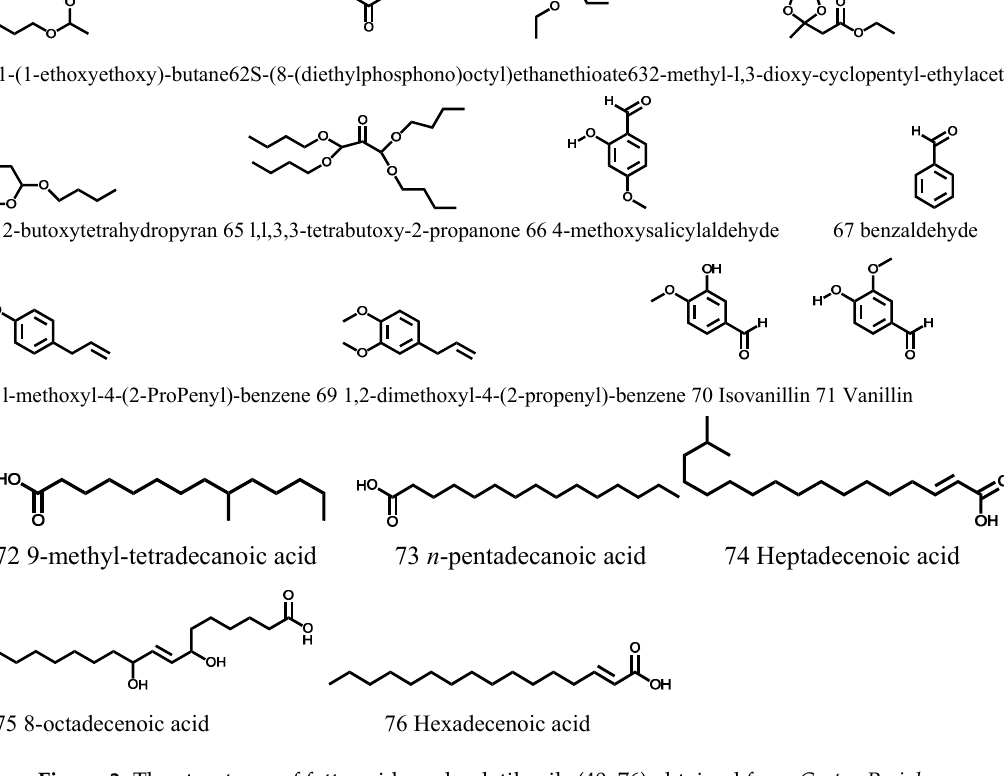
Figure 3. The structures of fatty acids and volatile oils (40–76) obtained from Cortex Periplocae .